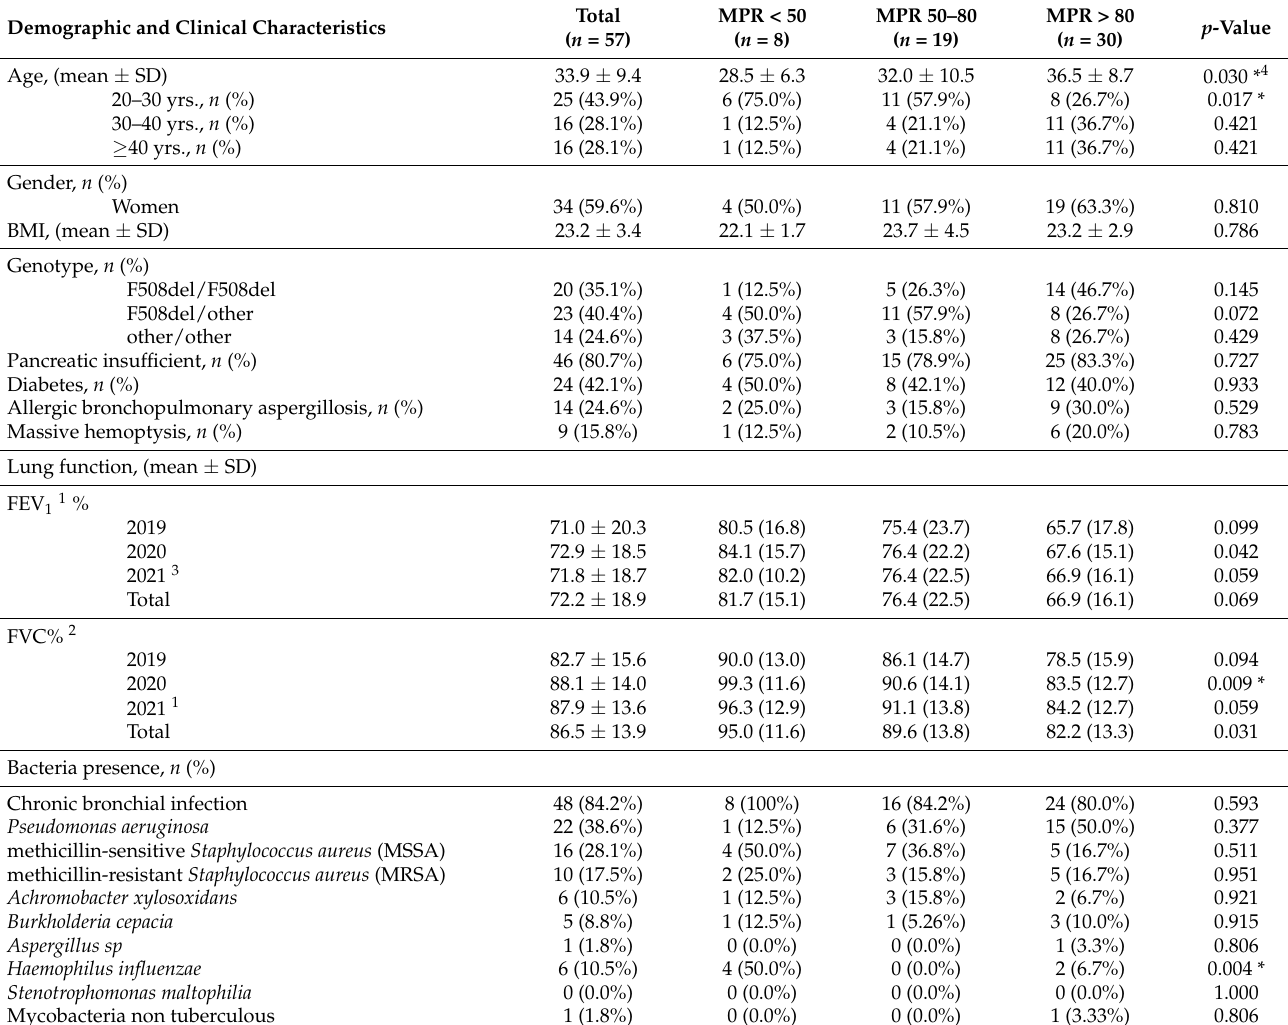
Table 1. Demographic and clinical characteristics for the total number of patients and for each compliance